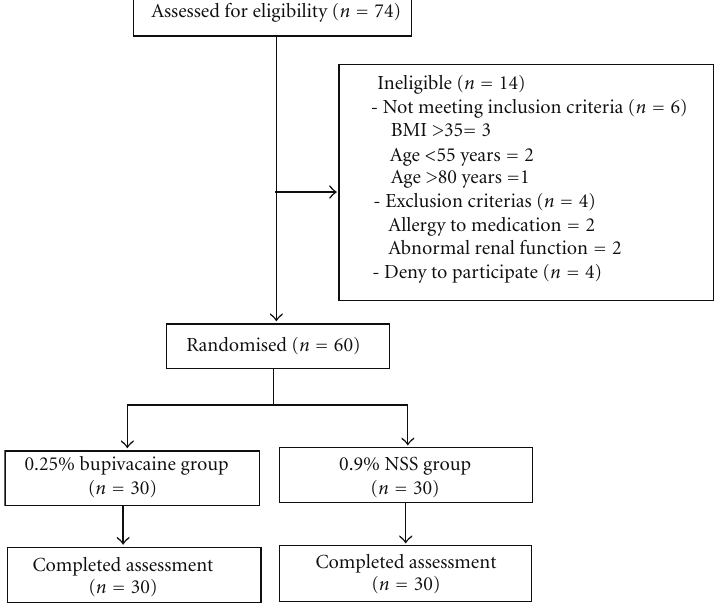
Figure 1: Participants flow.